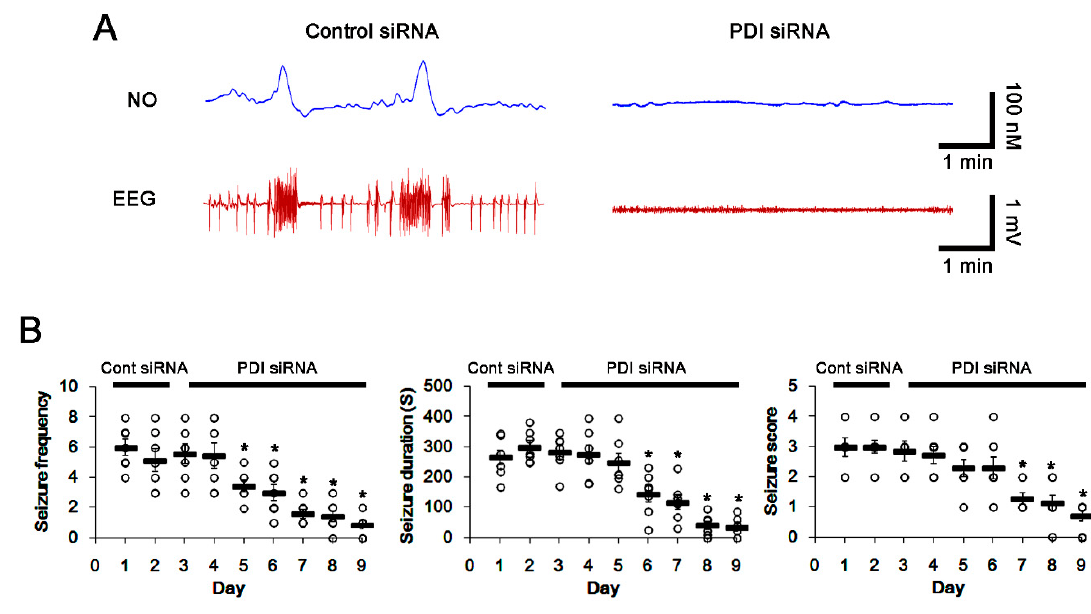
Figure 5. E ff ect of PDI knockdown on spontaneous seizure activity and NO generation in epilepsy. ( A ) Representative NO concentration and EEG trace for control siRNA-infused and PDI siRNA-infused epilepsy animals. In control siRNA-infused animals, NO level immediately rises after spontaneous seizure onset, and gradually decreases to basal level after seizure cessation (left panel). In PDI siRNA-infused animals, there is no alteration in NO level, due to the absence of spontaneous seizure activity (right panel). ( B ) Anticonvulsive e ff ect of PDI siRNA on spontaneous seizure activity: the mean seizure frequency (left), seizure duration (middle) and behavioral seizure score (right). Open circles indicate each individual value. Horizontal bars indicate mean value. Error bars indicate SEM (* p < 0.05 vs. control siRNA, Kruskal–Wallis test with Dunn’s multiple comparison test, n = 7, respectively). PDI knockdown inhibits the spontaneous seizure activity in epileptic rats.